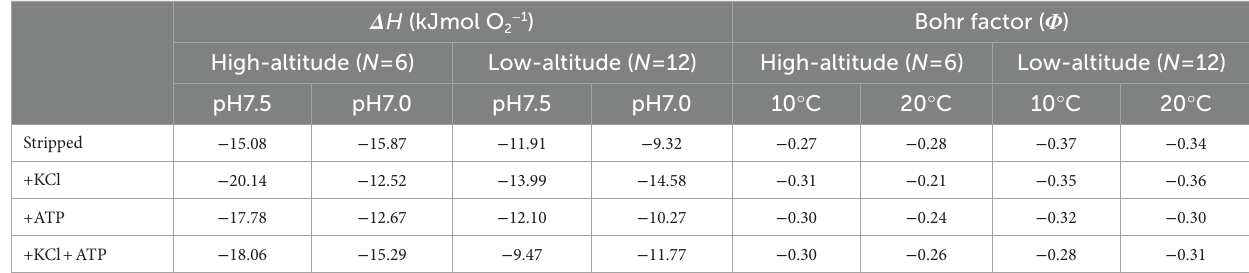
TABLE 5 Temperature effect (indexed as enthalpy of oxygenation ( Δ H )) and Bohr effect (indexed as Bohr factor) on oxygen affinity of high- and low- altitude black spotted frogs Hbs under different experimental